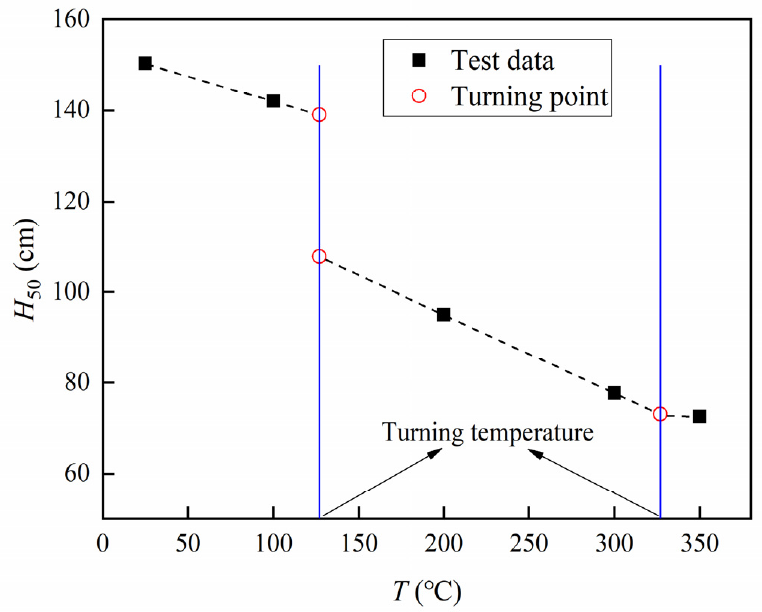
Figure 6. Temperature interval effect of impact